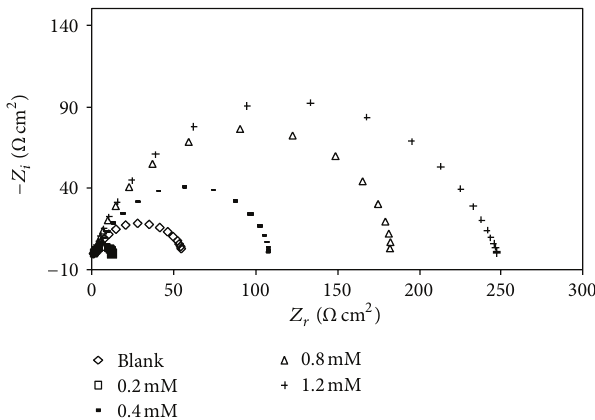
Figure 9: Nyquist diagrams for C38 steel in 1M HCl containing 0.2 mM of norharmane at different temperatures.